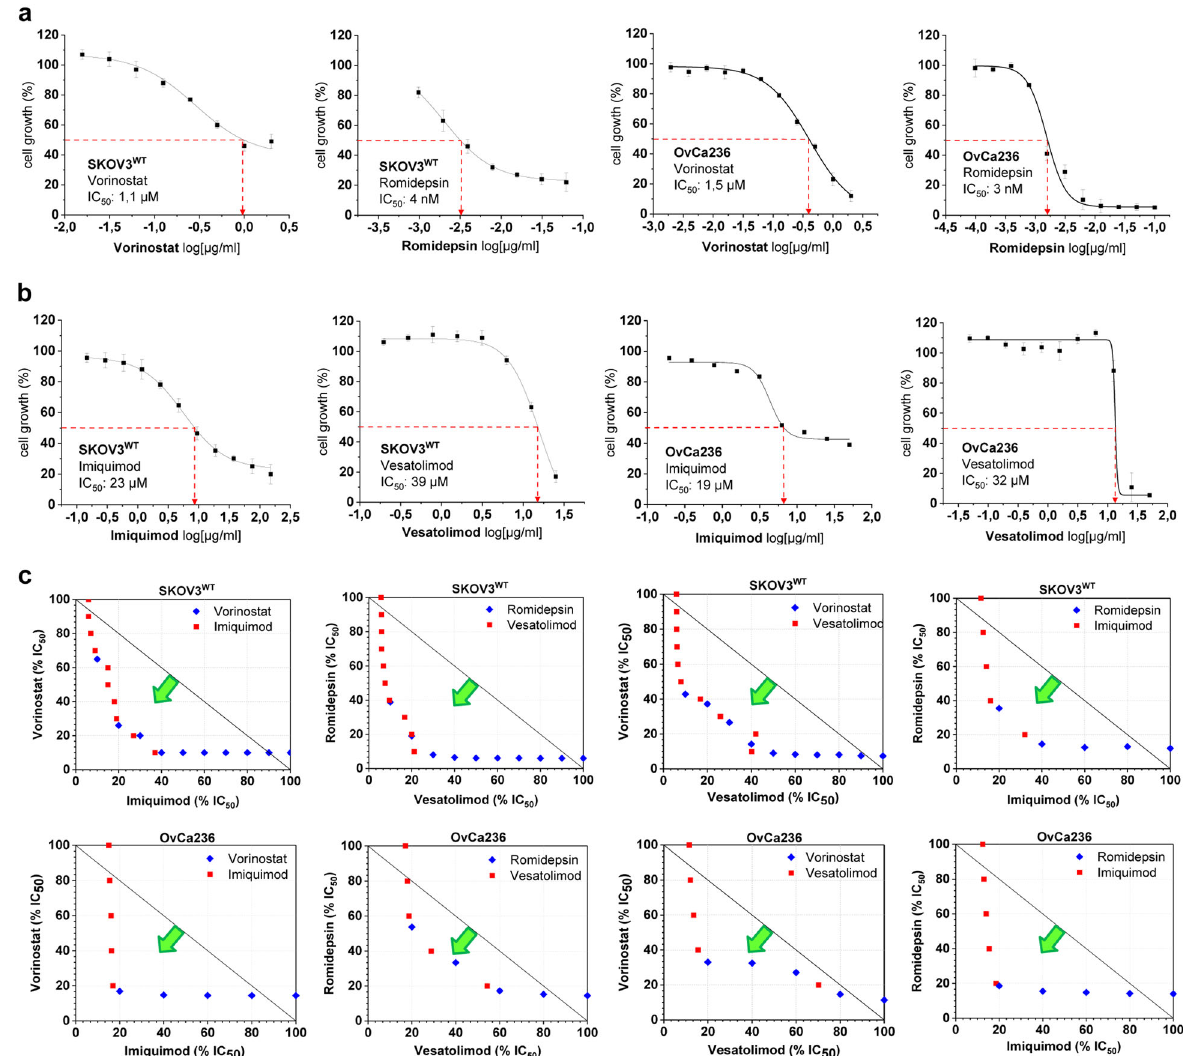
Fig. 2 Cytotoxicity and interaction of HDACis and TLR7as in ovarian carcinoma cells. a The cytotoxicity of the HDACis vorinostat and romidepsin in SKOV3 WT and OvCa236 primary ovarian carcinoma cells was determined using the MTT proliferation assay after 72 h of drug exposure. Vorinostat and romidepsin are very cytotoxic in ovarian carcinoma cells (IC 50 ~ 4 nM). b The TLR7as imiquimod and vesatolimod were tested in the same manner as the HDACis proved less cytotoxic in these carcinoma cell types, with IC 50 values between 23 and 32 µ M. These values were employed as reference in all subsequent biochemical experiments. The graphs are representative of n = 5 experiments. c HDACi/TLR7a interaction was analysed using isobolographic methods in SKOV3 WT and OvCa236 primary ovarian carcinoma cells isolated from ascites. The combination of HDACis and TLR7as produces a synergistic effect regardless of pairing (green arrows). Results are representative of n = 5